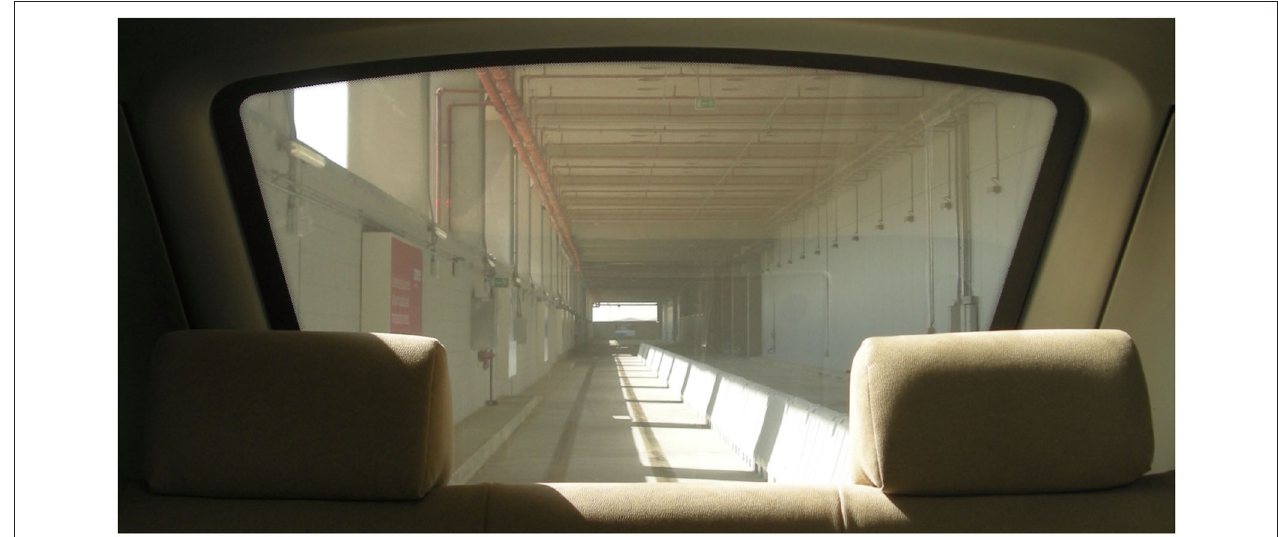
FIGURE 2 | View from inside a PRT vehicle in motion. The machine is traversing Masdar City’s undercroft. The two parallel lines visible on the road ahead form the track that the PRT car is following. Source: author’s